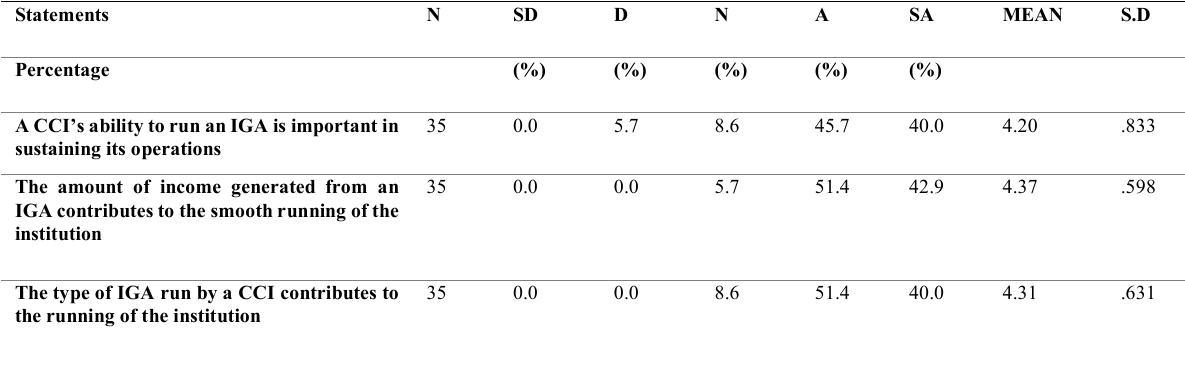
Table 2: Distribution of responses on income-generating activities on management of